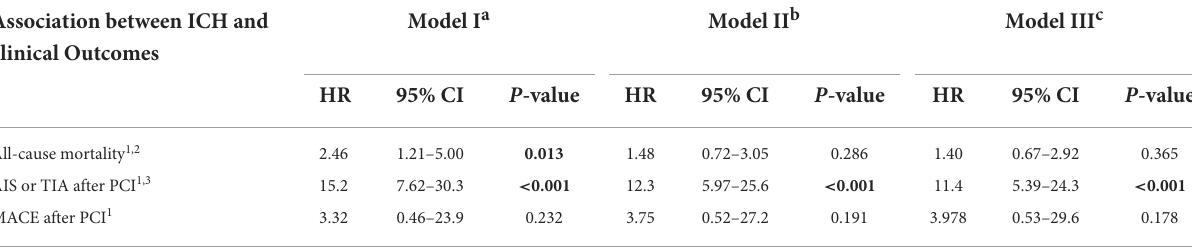
TABLE 3 Cox-proportional hazards models showing the association between intracerebral hemorrhage after non-emergency percutaneous coronary intervention and clinical outcomes. Association between ICH